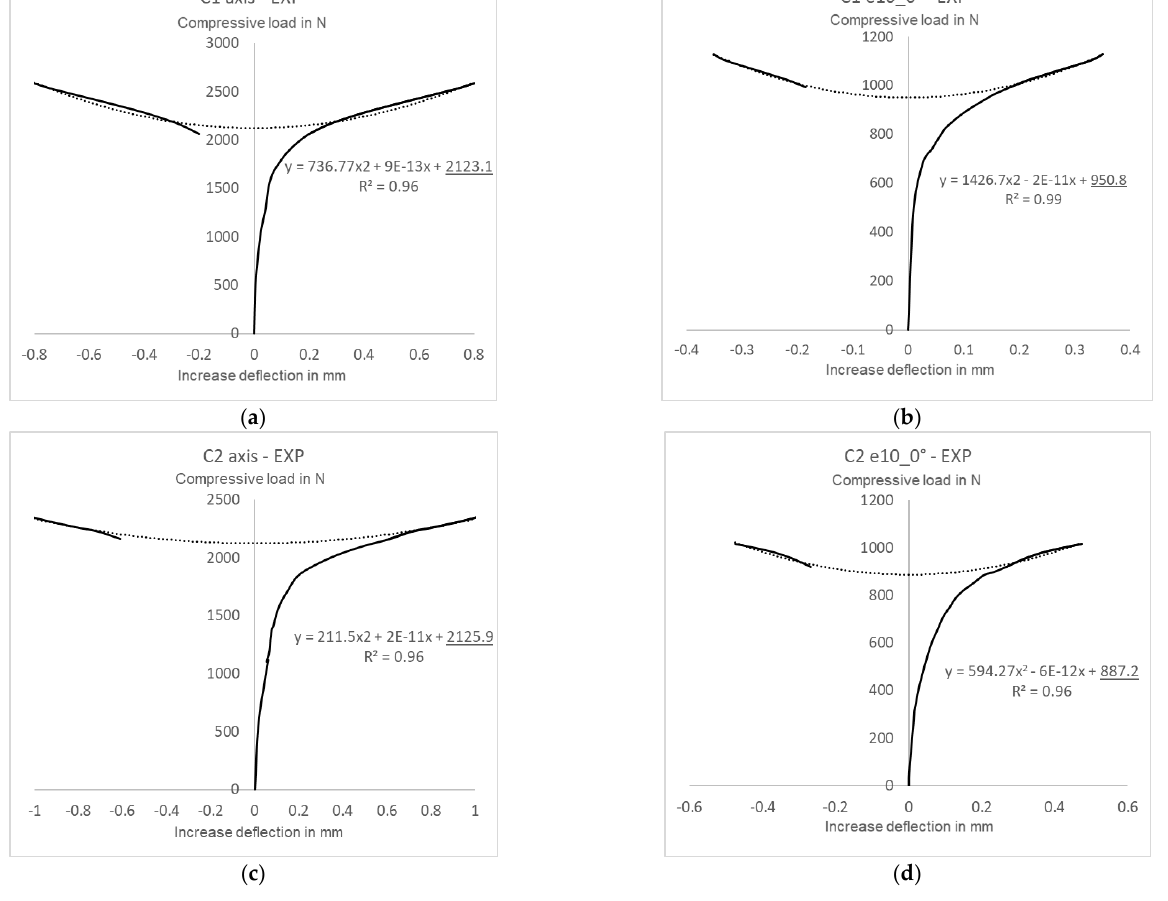
Figure 12. Experimental critical loads for structures with initial imperfections: ( a ) C1 axis, ( b ) C1 e10_0°, ( c ) C2 axis, ( d ) C2 e10_0°. Table 2. Critical loads for structures with initial